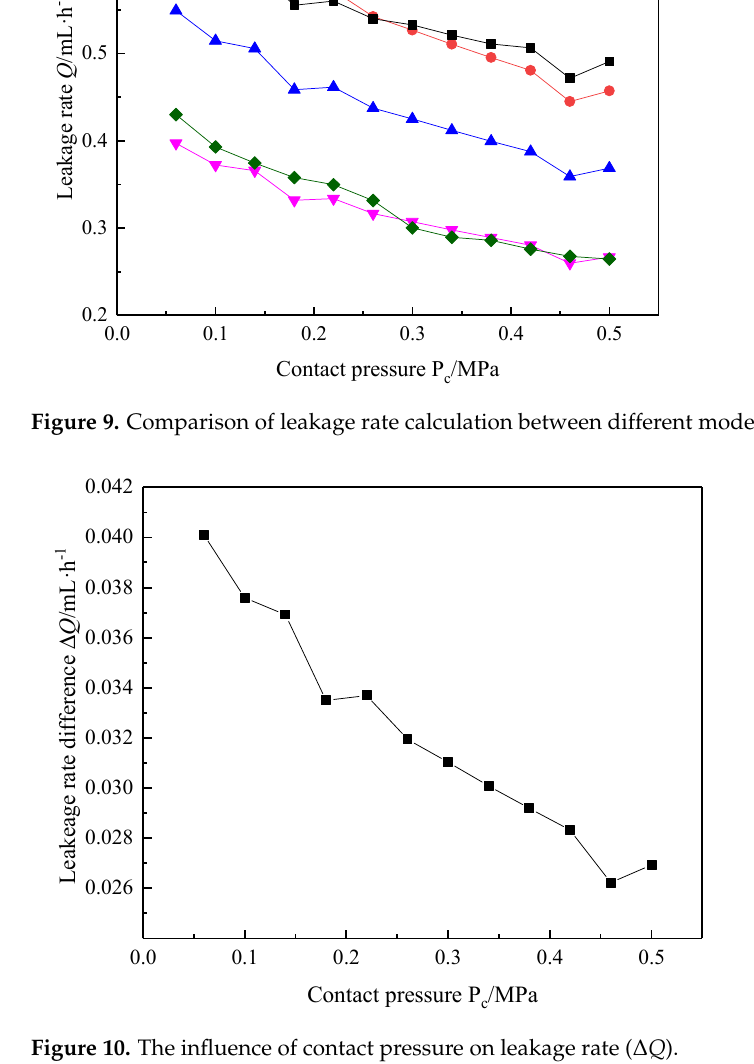
Figure 9. Comparison of leakage rate calculation between different models.